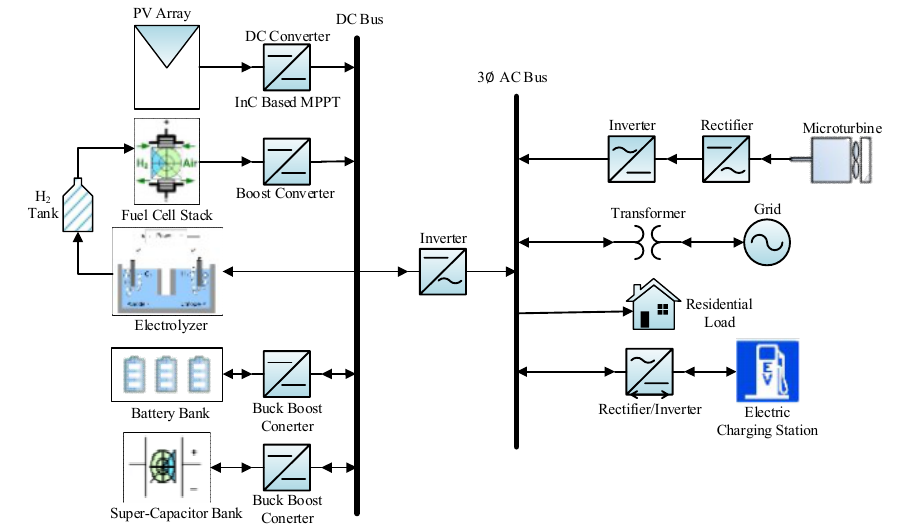
Figure 1. Proposed hybrid smart micro-grid system. Table 1. RESs and their power converter parameters [36,38,42–44].